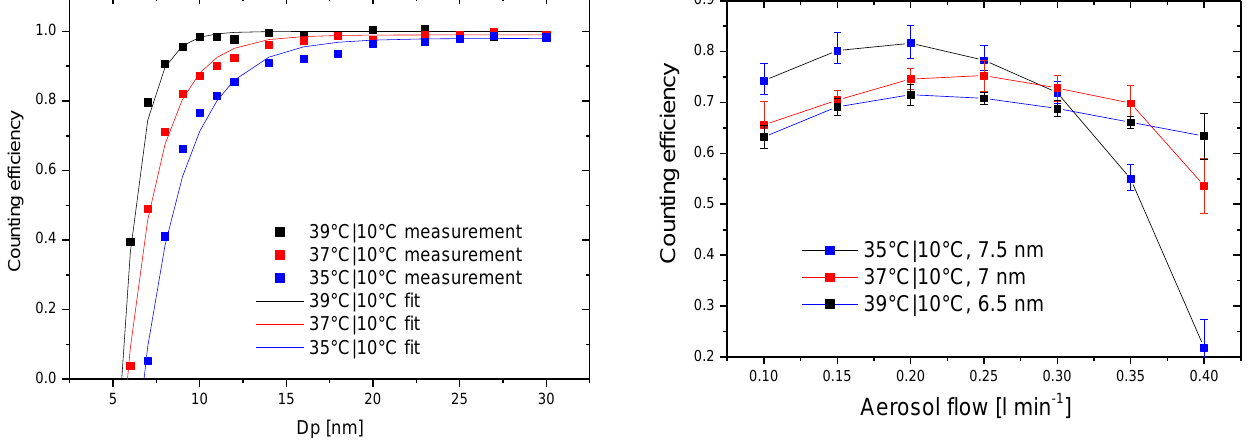
Fig. 2. Counting efficiency of the Fast CPC at different tempera- ture differences compared to the electrometer (TSI 3068B). Squares present the mean measurement points, the solid lines are fitted us- ing Eq. (1). The corresponding fit parameters as well as the 50% detection diameter D P50 are given in Table 1.